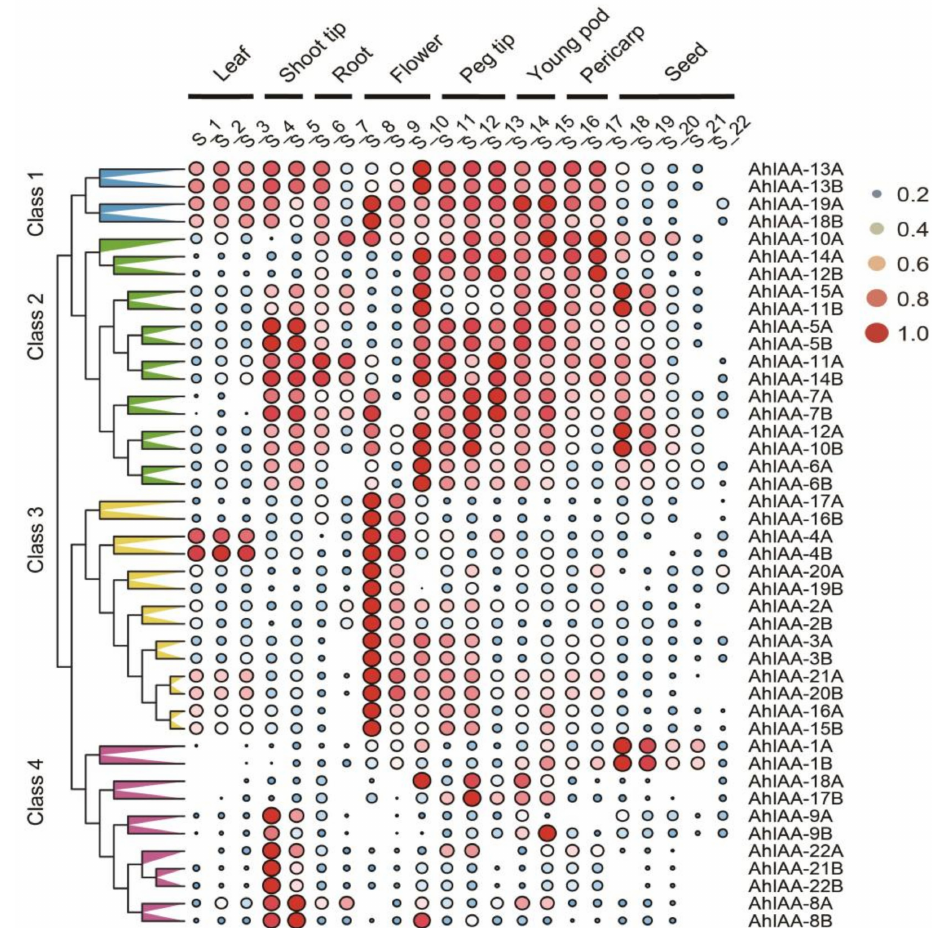
were normalized by log 2 and scaled to 0-1 within each